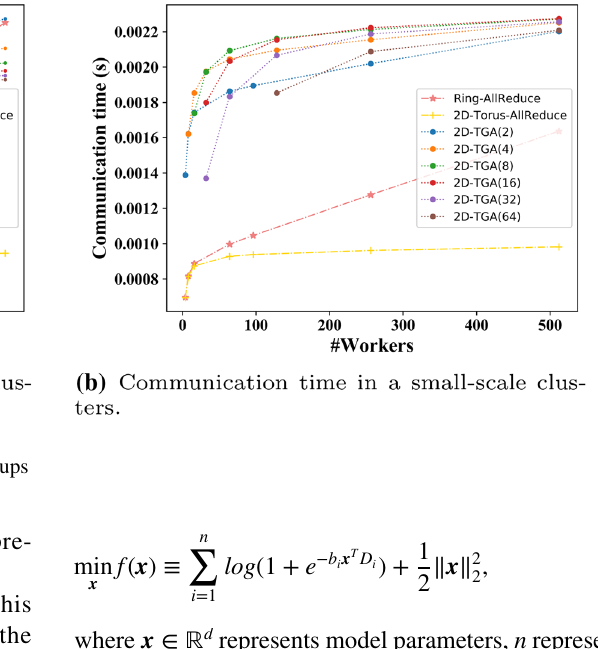
Fig. 3 Communication time of different synchronous algorithm